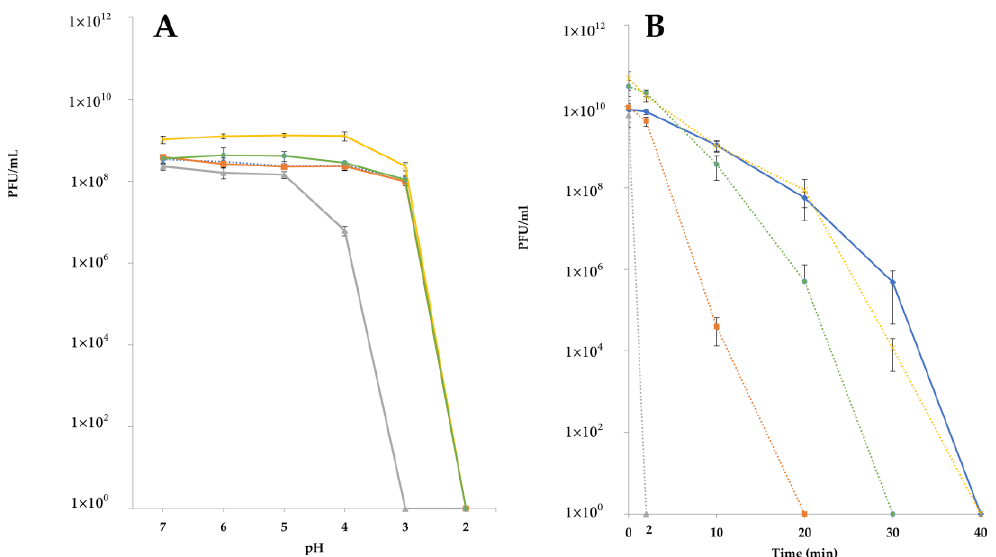
Figure 3. ( A ) Phage survival across a range of pH values: the graph shows the phage counts of each of the tested phages after 1 h incubation at 37 °C and at specific pH values. ( B ) Phage survival in SGF, pH 2, over time; the graph shows the phage counts of each of the tested phages after 0, 2, 10, 20, 30, and 40 min of incubation in SGF. Each colored line represents a distinct phage: blue = JK1; orange = JK08; grey = JK16; yellow = JK36; and green = JK38. All assays were performed in triplicates and the graphs represent the average and standard deviation error bars of these data.